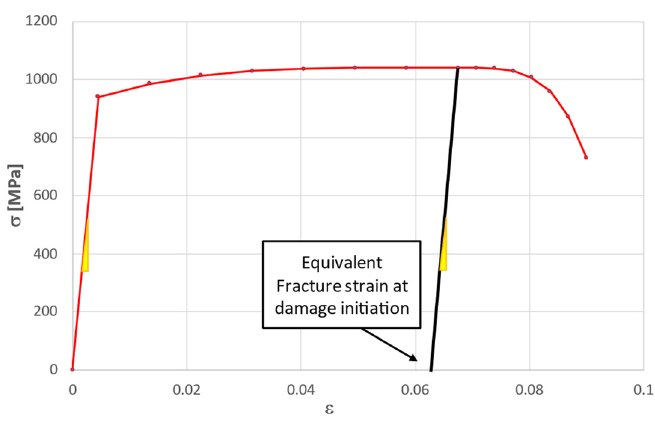
Figure 4. Equivalent strain at damage initiation computation.